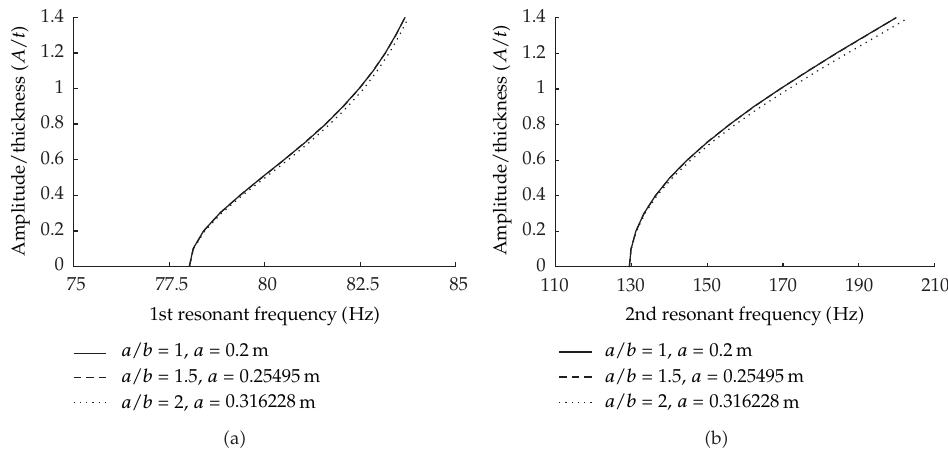
Figure 5: (cid:3) a (cid:6) The vibration amplitude ratio versus the 1st nonlinear resonant frequency (cid:3) a/b (cid:7) 1 . 0, 1.5, 2.0 (cid:6) . (cid:3) b (cid:6) The vibration amplitude ratio versus the 2nd nonlinear resonant frequency (cid:3) a/b (cid:7) 1 . 0, 1.5, 2.0 (cid:6) .